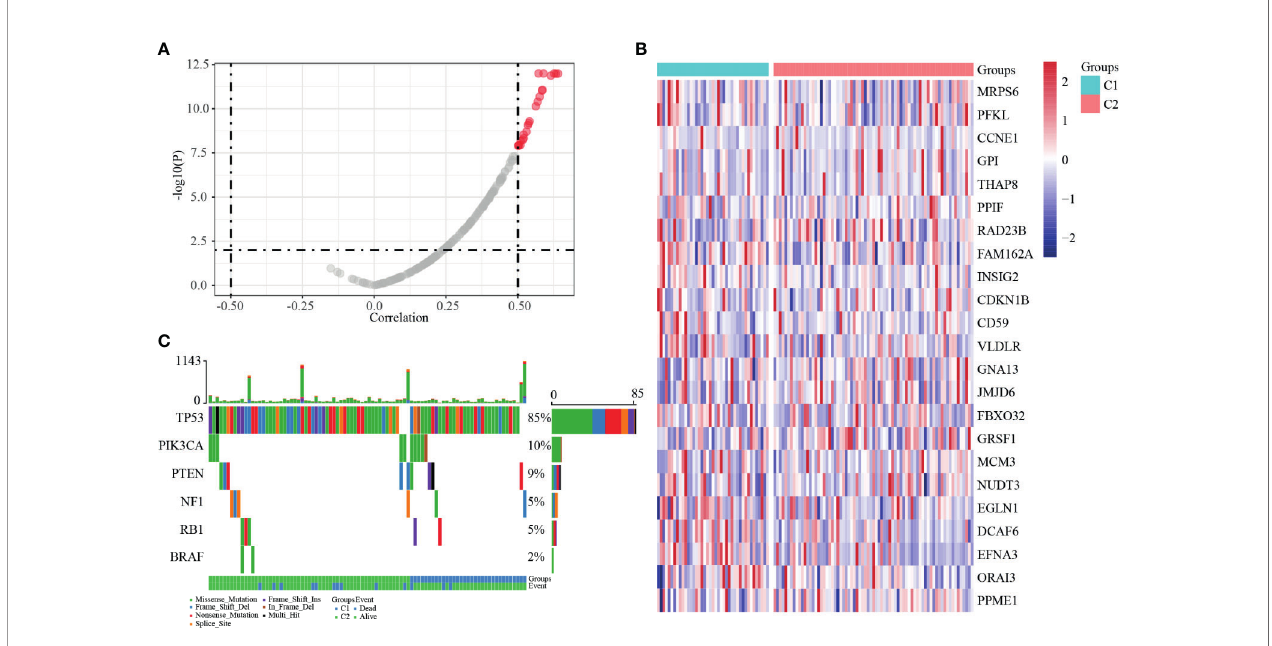
FIGURE 6 | SSNV and SCNV characteristics of dHRGs. (A) The correlation coef fi cient and p -value between the expression level of dHRGs and CNV. (B) The expression level of 23 dHRGs in different groups of TCGA-TNBC. (C) The mutation distribution of speci fi c genes in different groups of TCGA-TNBC.